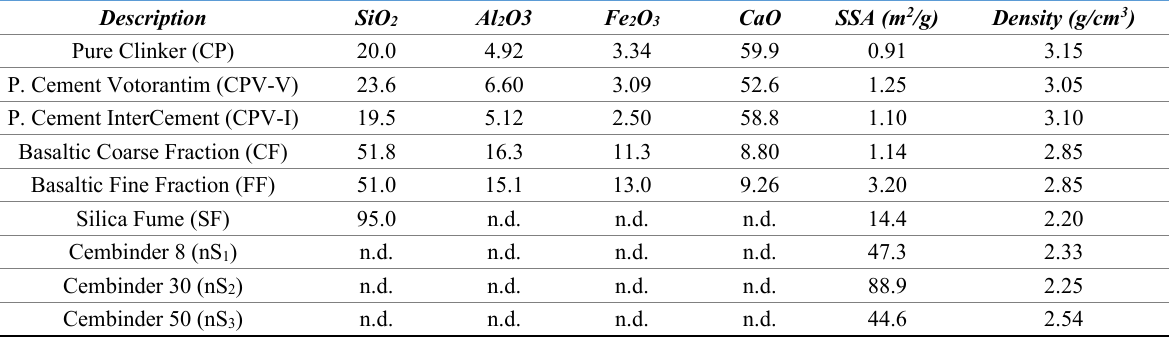
Table 1. Physical properties and chemical composition (wt.%) of raw-materials Description SiO 2 Al 2 O3 Fe 2 O 3 CaO SSA (m 2 /g) Density (g/cm 3 ) Pure Clinker (CP) 20.0 4.92 3.34 59.9 0.91 P. Cement Votorantim (CPV-V) 23.6 P. Cement InterCement (CPV-I) Basaltic Coarse Fraction (CF) Basaltic Fine Fraction (FF) Silica Fume (SF)